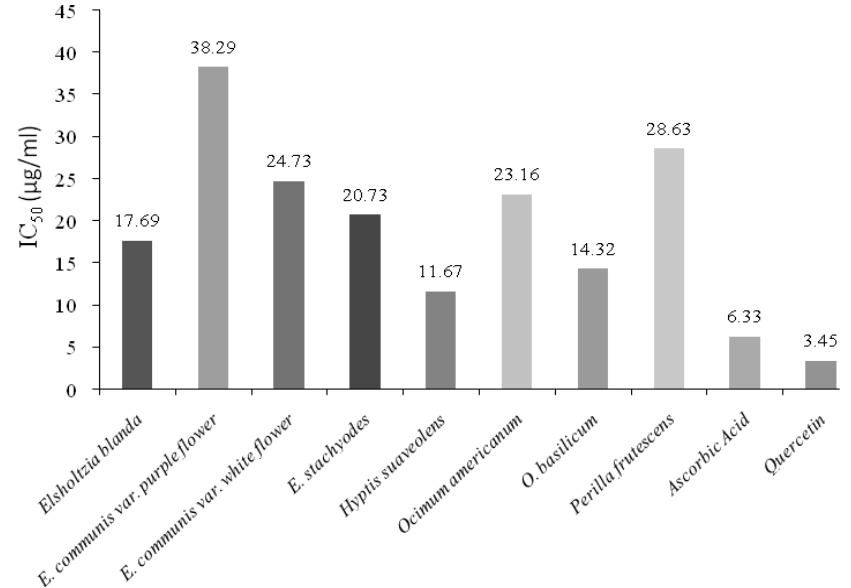
Fig.1. Free radical scavenging activity of the eight Lamiaceae plants of Manipur